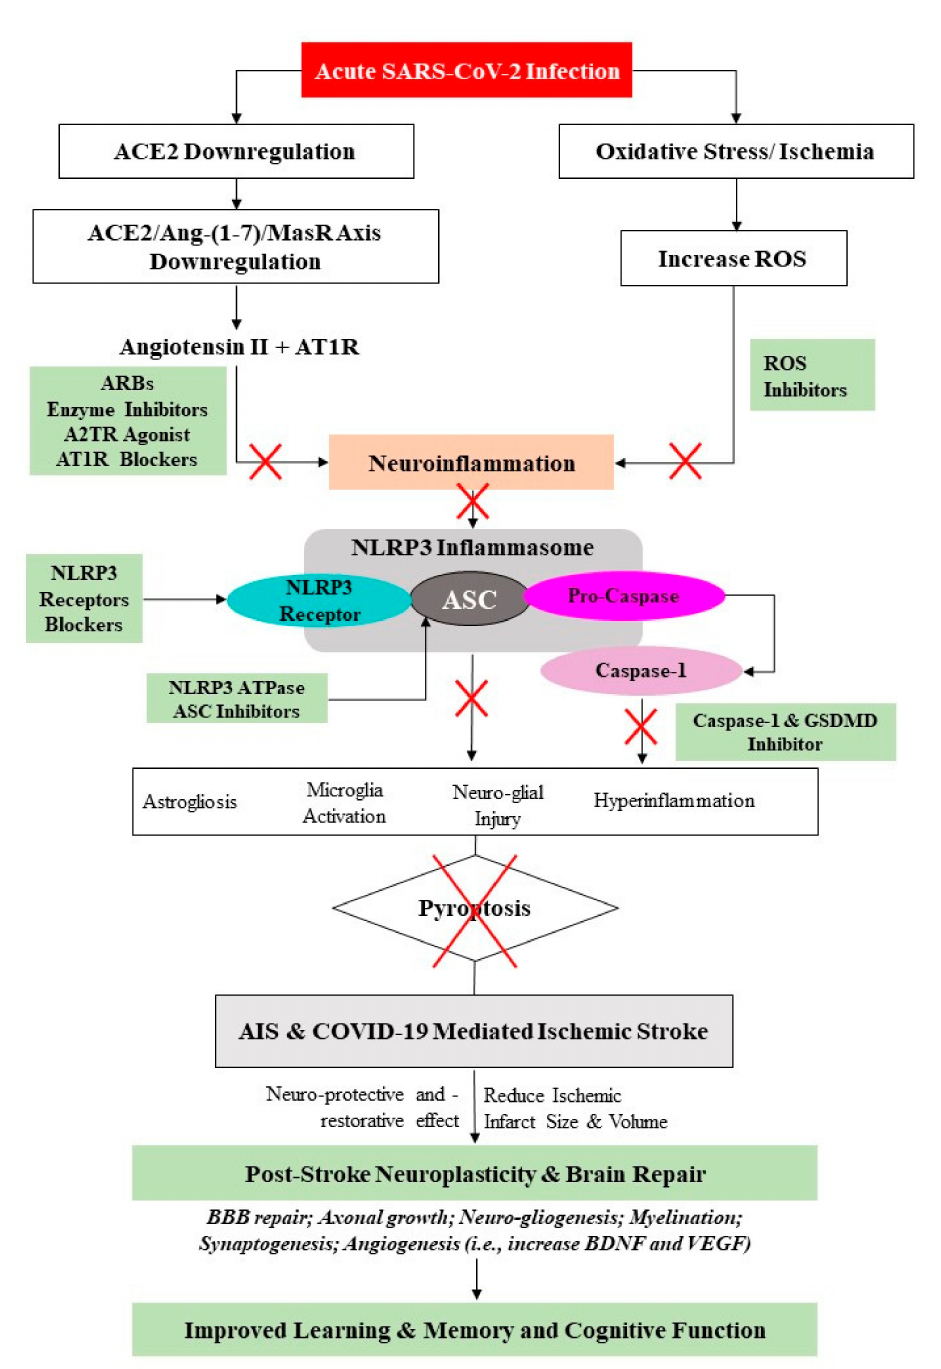
Figure 4. Proposed mediating role of ACE2/Ang-(1-7)/MasR axis and NLRP3 inflammasome in AIS and COVID-19-mediated ischemic stroke and the prospects of these neuroinflammation mediators for brain repair and in secondary prevention strategies against AIS in stroke